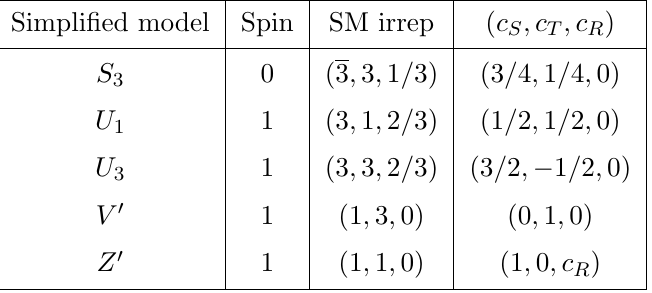
Figure 1 . Limits in the plane ( (cid:30); (cid:18) ) for two choices of the phases (cid:11) bs and (cid:11) bd from observables with direct correlation with R . The blue contours correspond to the value of j C L j (cid:0) 1 = 2 in TeV, where K ( (cid:3) ) solid (dashed) lines are for positive (negative) C L . The meshed red region correspond to the one suggested by partial compositeness or SU(2) q -like (cid:13)avor symmetry, eq. (4.5) with j a bd;bs j 2 [0 : 2 (cid:0) 5]. Simpli(cid:12)ed model Spin